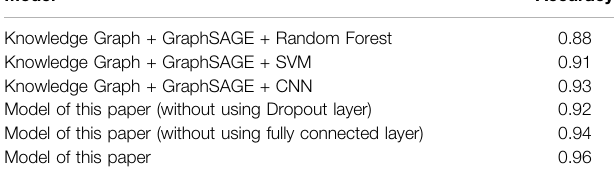
TABLE 5 | Classi fi cation model comparison.